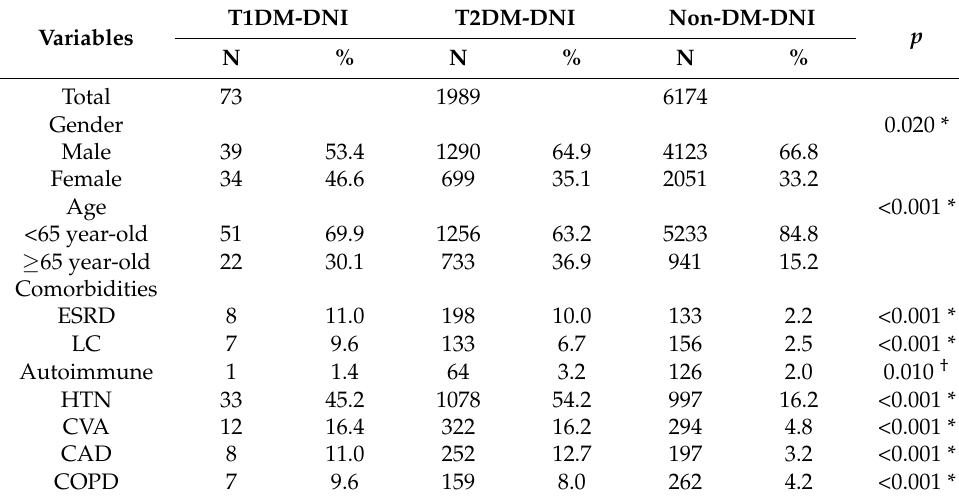
Table 1. Demographic characteristics between DNI in T1DM, T2DM, and